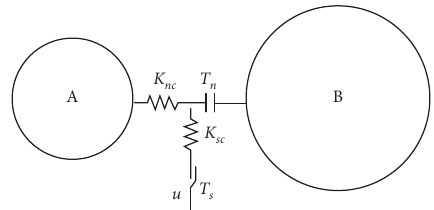
Figure 5: PFC 2D microscopic contact constitutive